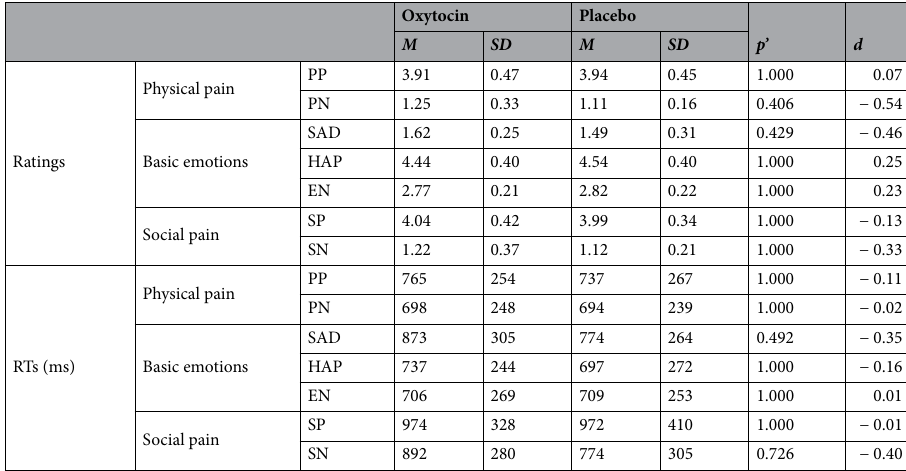
Table 2. Summary of behavioral data. p -values derive from paired t -tests comparing mean ratings after oxytocin and placebo administration. Values in the p ′ -column represent p -values adjusted for multiple comparisons using the Holm-Bonferroni correction while keeping the significance level of p < 0.05 constant. p ′ -values of 1.000 denote upper bound estimates. Data derived from n = 25 patients for the physical pain experiment, n = 23 for the basic emotions experiment, and n = 21 for the social pain experiment. RT Reaction time, PP physical pain, PN physical neutral, SAD Sad, HAP Happy, EN emotional neutral, SP social pain, SN social neutral, M mean, SD standard